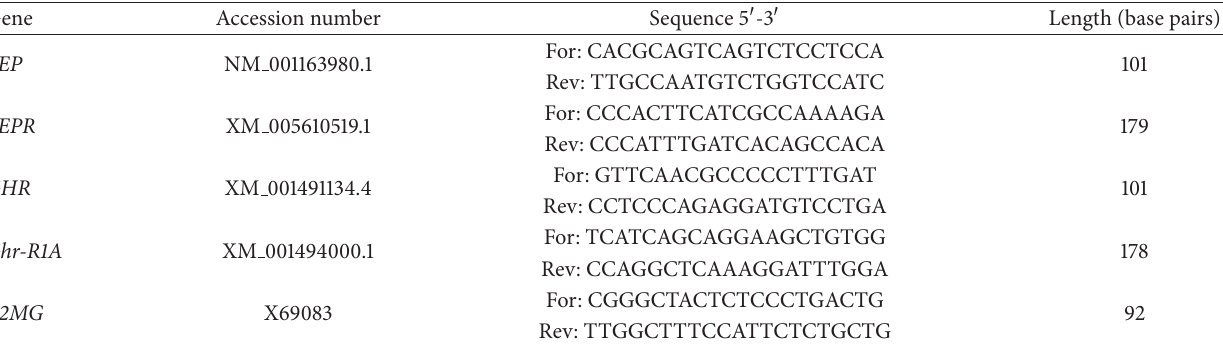
Table 1: Specific primer sequences used for quantitative real-time